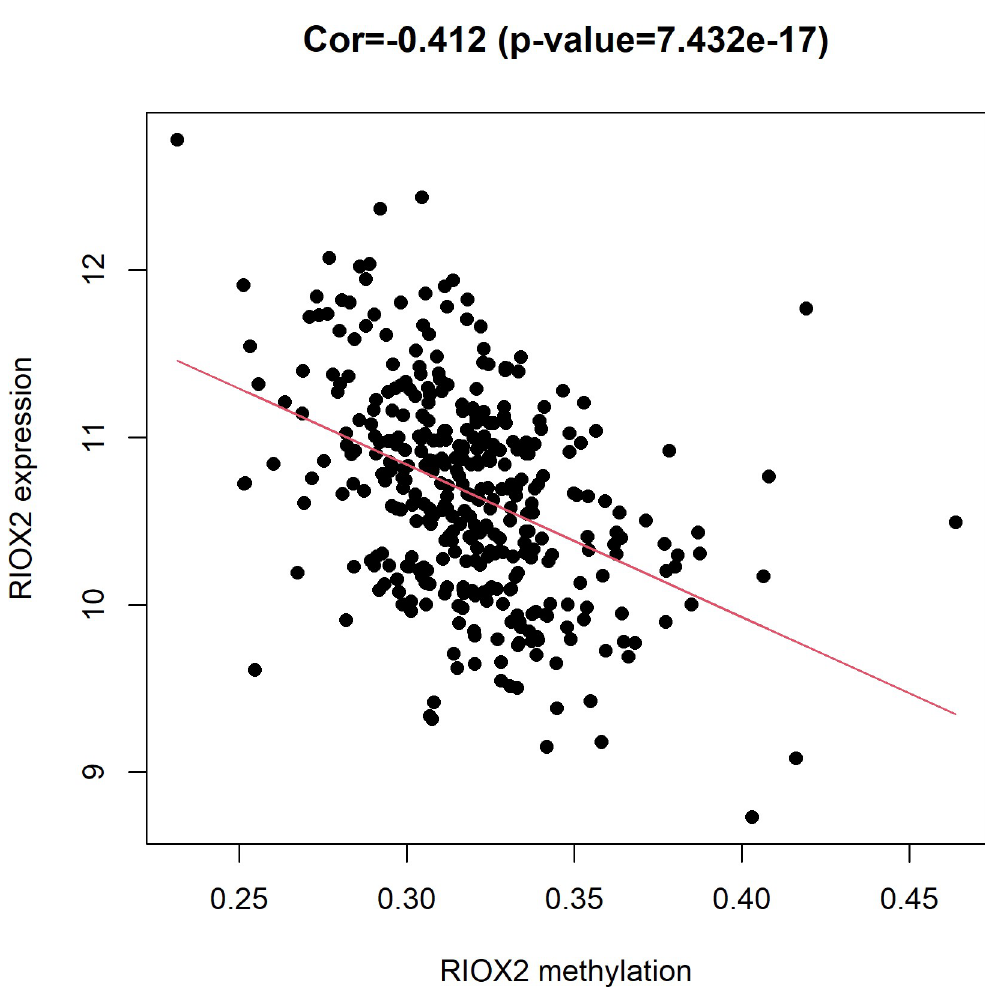
Fig 8. The relationship between RIOX2 gene expression and methylation levels in lung squamous cell carcinoma. The horizontal coordinate is the RIOX2 methylation level, and the vertical coordinate is the RIOX2 gene expression level.